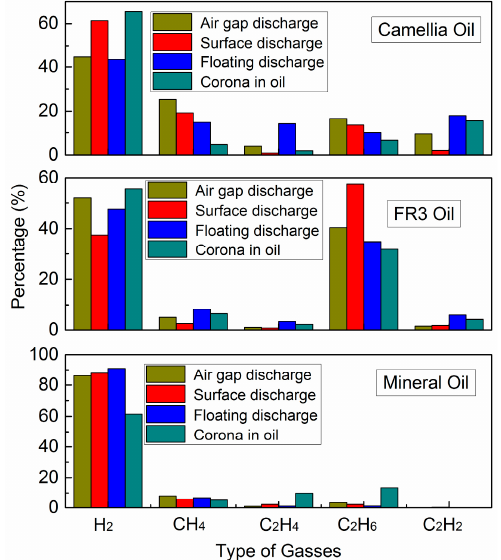
Figure 13. Relative percentages of fault gases in oil under partial discharge.